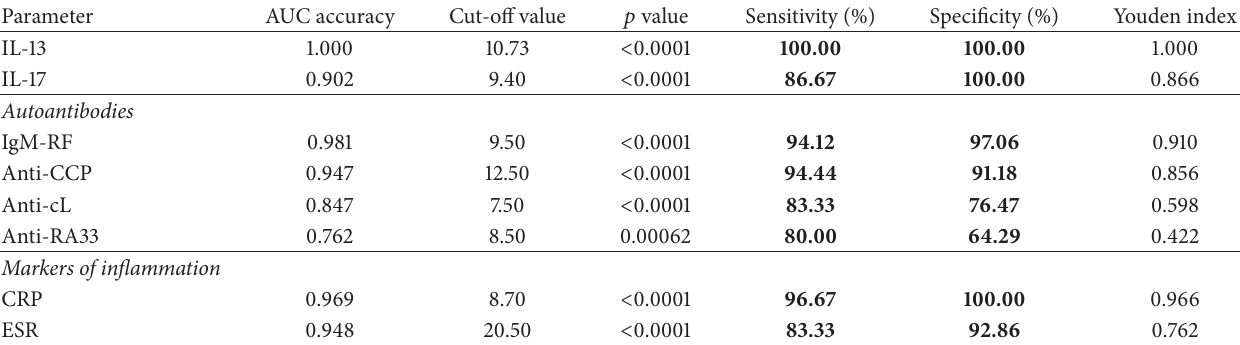
Table 4: Diagnostic performance of the investigated